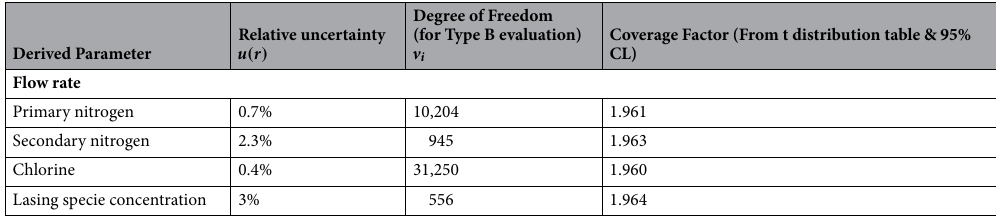
Table 7. Relative uncertainty in derived parameter